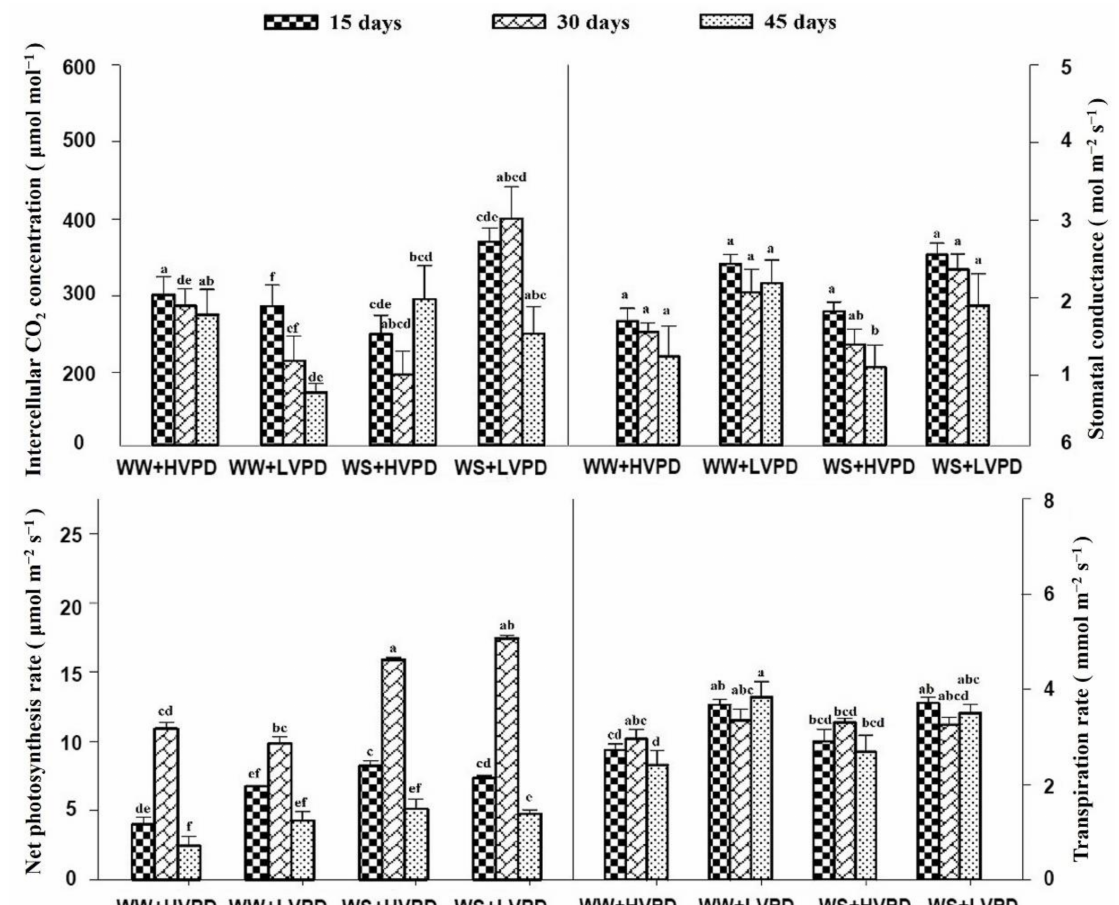
Figure 5. Effects of VPD and soil moisture on the net photosynthesis rate (Pn), intercellular carbon dioxide concentration (Ci), stomatal conductance (Gs), and transpiration rate (Tr) of cucumber plants. Data represent means ± standard error ( n = 10). Letters represent significant differences between treatments. Different letters indicate significant differences ( p < 0.05). WW (well-watered. 100%FC) + HVPD (high vapor pressure deficit); WW (well-watered, 100%FC) + LVPD (low